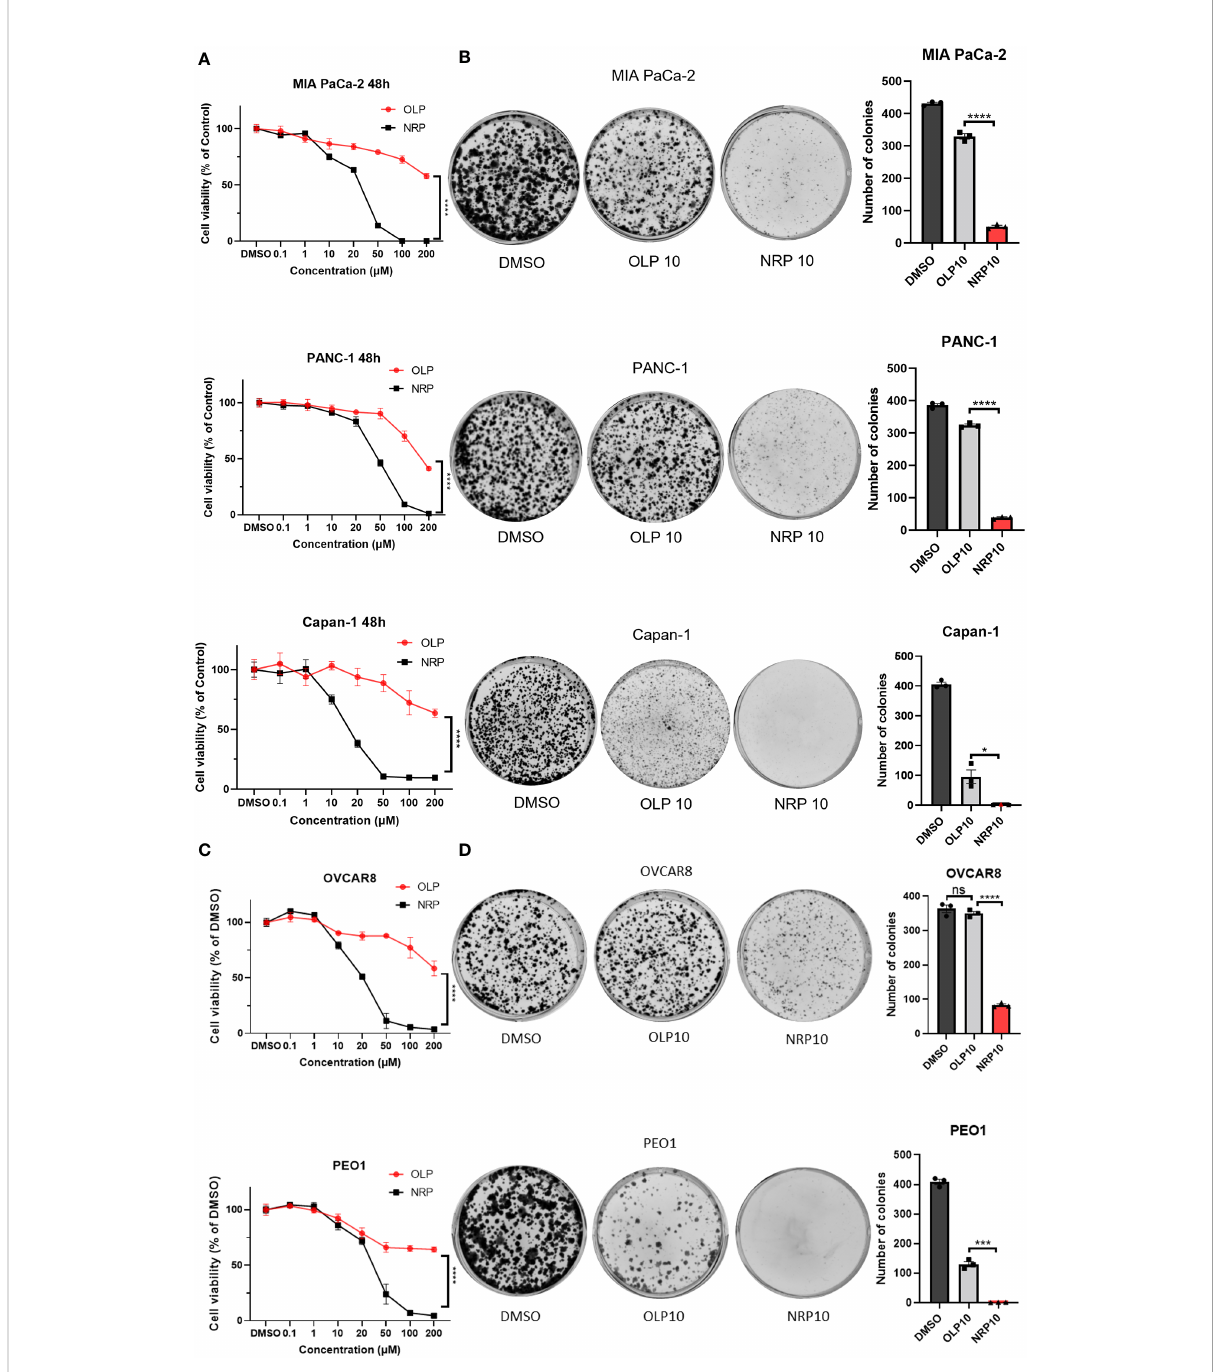
FIGURE 1 Niraparib (NRP) exhibits more potent antitumor effects than Olaparib (OLP) on PDAC cancer cells with or without BRCA mutations as well as on ovarian cancer (OvCa) cells. (A) PDAC cell lines MIA PaCa-2, PANC-1, and Capan-1 were treated with NRP or OLP for 48h. Cell viability was assessed by CellTiter-Glo assay. The data shown are representative of three independent experiments. Two-way ANOVA, ****p<0.0001. (B) A colony formation assay was conducted to determine the long-term antitumor effects of NRP and OLP on PDAC cancer cells. The representative images of three independent tests are shown. The number of colonies was counted, and data are shown as mean ± SEM (N=3). Unpaired two- tailed Student t-test, *p<0.05, ****p<0.0001. (C) Cell viability assay was conducted on OvCa cell lines OVCAR8 and PEO1 under the same treatment as in (A) . Results are representative of three independent experiments. Two-way ANOVA, ****p<0.0001. (D) Colony formation assay on OVCAR8 and PEO1 cells. The representative images of three independent experiments are shown here with the quanti fi cation of colonies. Data shown are shown as mean ± SEM (N=3). Unpaired two-tailed Student t-test, ns, not signi fi cant, ***p<0.0001,